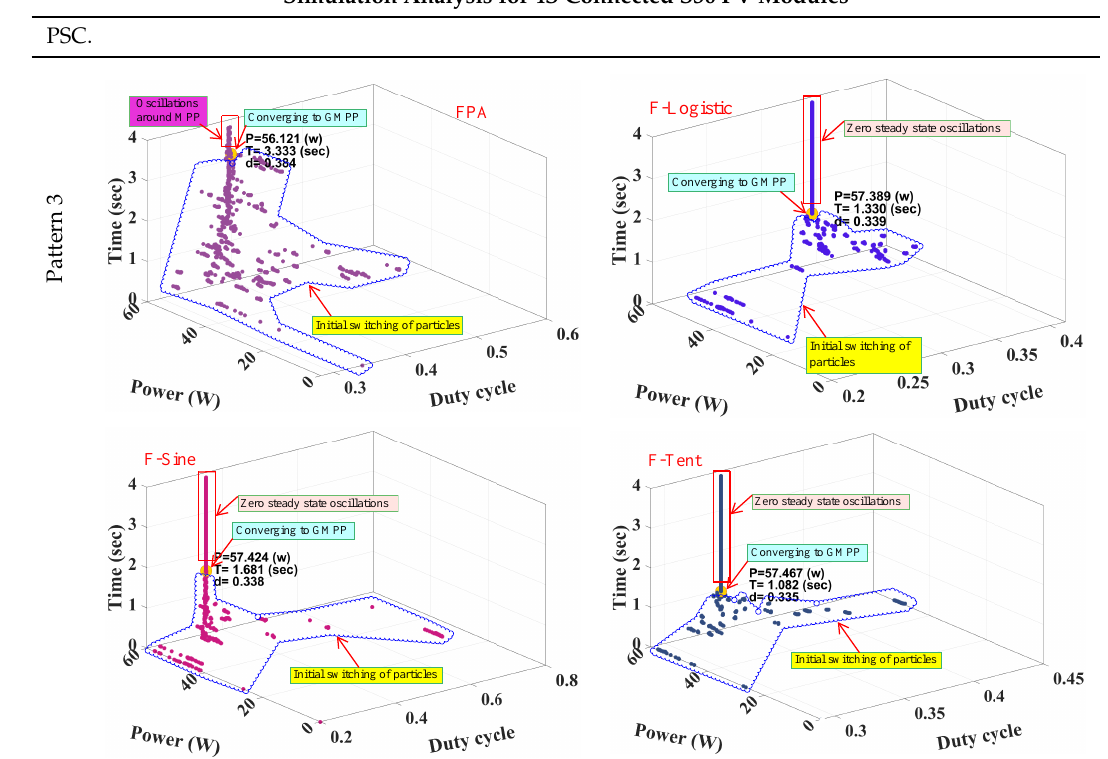
Table 4. Cont . Simulation Analysis for 4S Connected S36 PV Modules PSC.